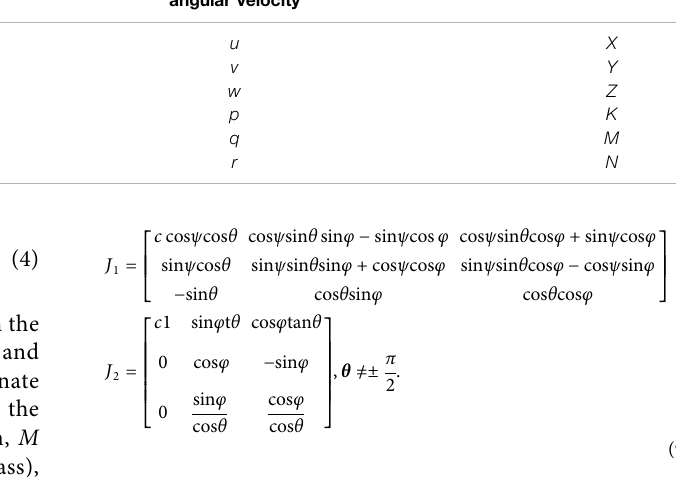
Linear velocity and angular velocity